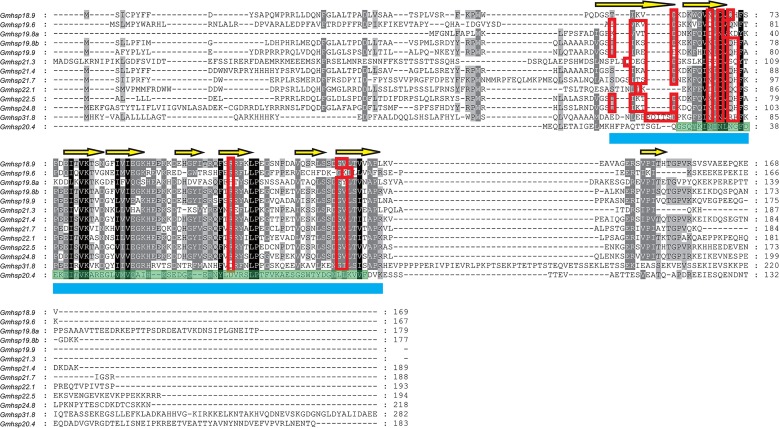
13 sHsp gene alignment of G. molesta.The predicted secondary structure showing the α-crystallin domain (ACD) is underlined by a blue solid line. Yellow arrows indicate β - strands. Red boxes indicate putative dimer interfaces. The green highlighted fragment is the ACD p23-like superfamily.